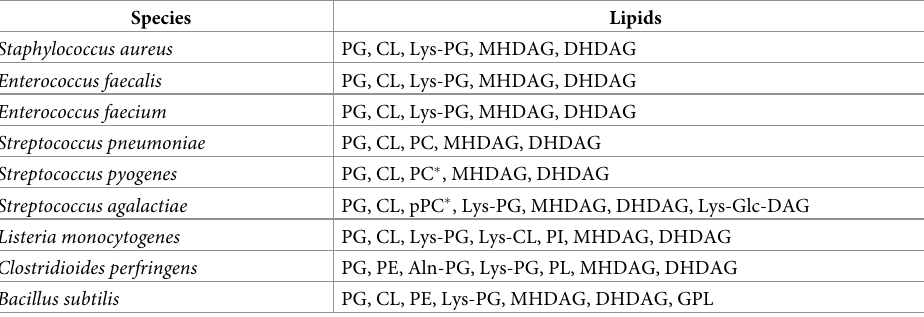
Table 1. Characterized lipids of select gram-positive